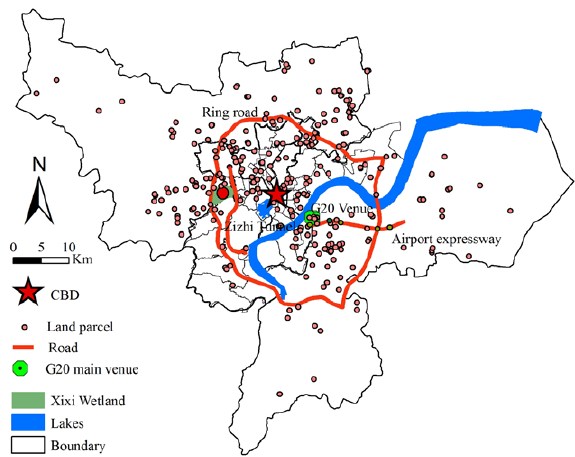
Figure 4. G20 venue, transportation infrastructure projects and land